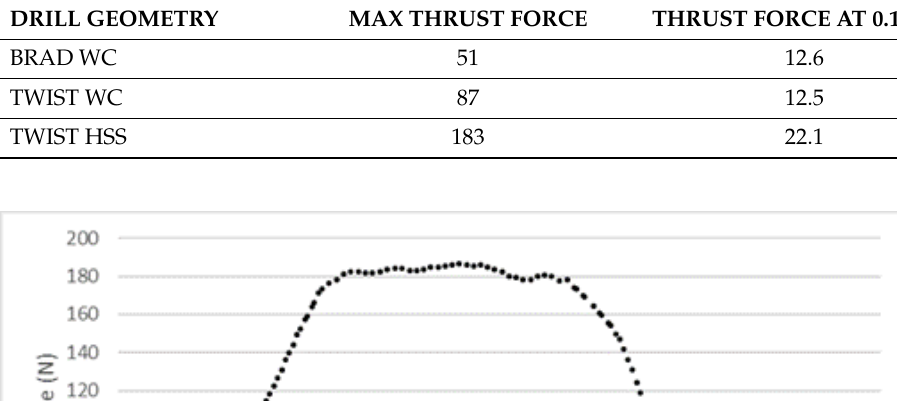
Table 3. Thrust forces: maximum and at 0.15 mm from breakthrough (values in N).